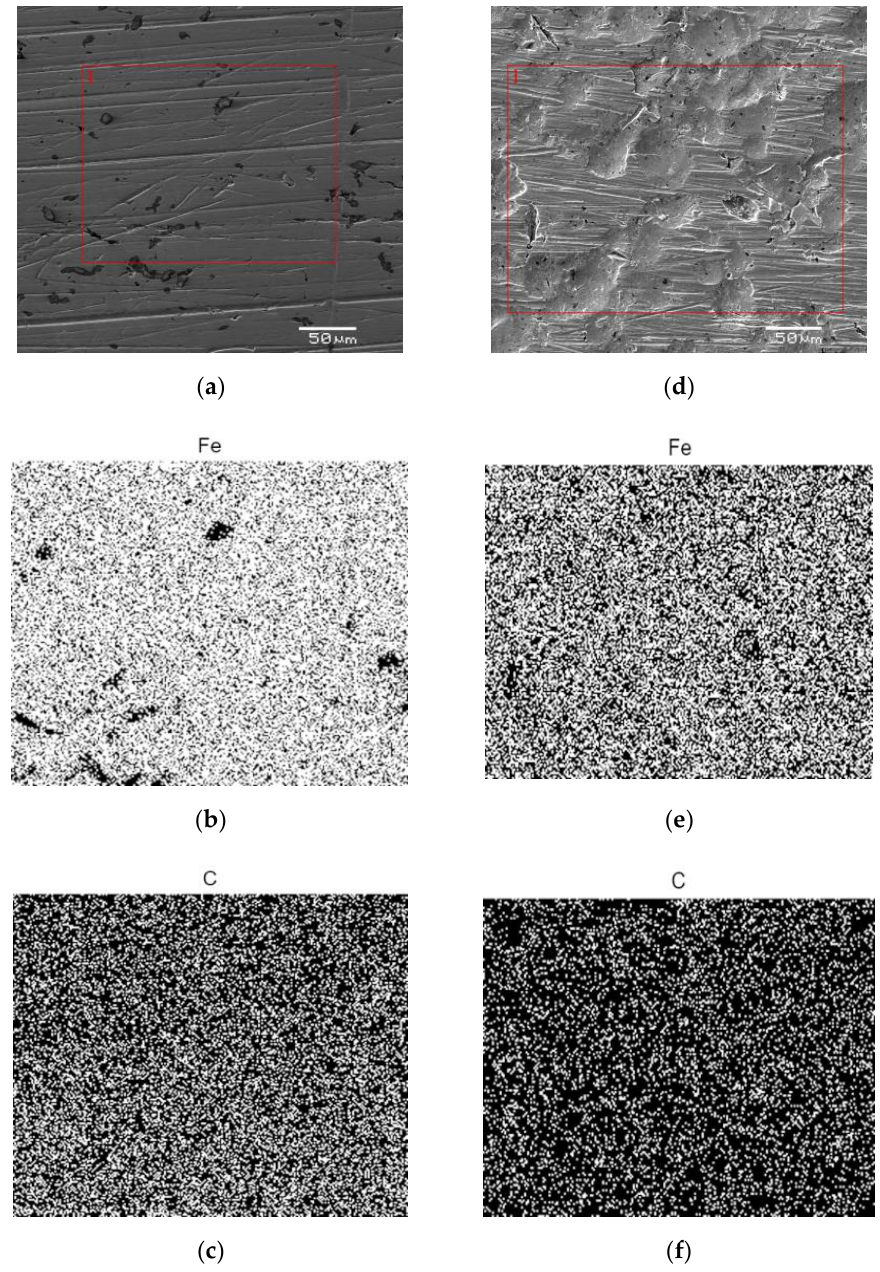
Figure 5. Exemplary images of iron and carbon elements distribution on the surface of AISI 1010 steel electrodes immersed in sulfolane at 95 ◦ C ( a – c ) and 230 ◦ C ( d – f ). Contact potential di ff erence ( CPD ) maps for the AISI 1010 steel electrodes are shown in Figure 7a–d. For each map, a corresponding histogram was prepared, as illustrated in Figure 8. Fitting the histograms with the Gaussian function (Equation (7)) allowed to quantify the material surface properties. In particular, it enabled to determine the average value of contact potential di ff erence ( CPD av ) and its standard deviation σ that are reported in Table